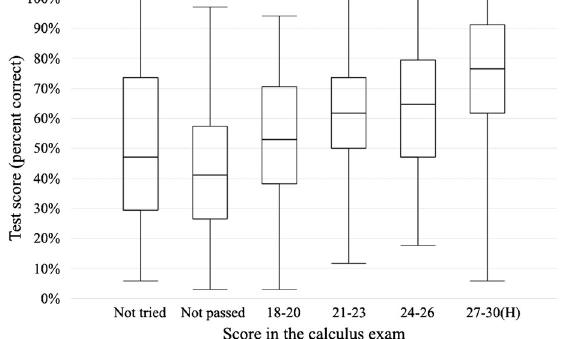
FIG. 2. The relationship between students ’ scores in the test and in the calculus exam they took in the first